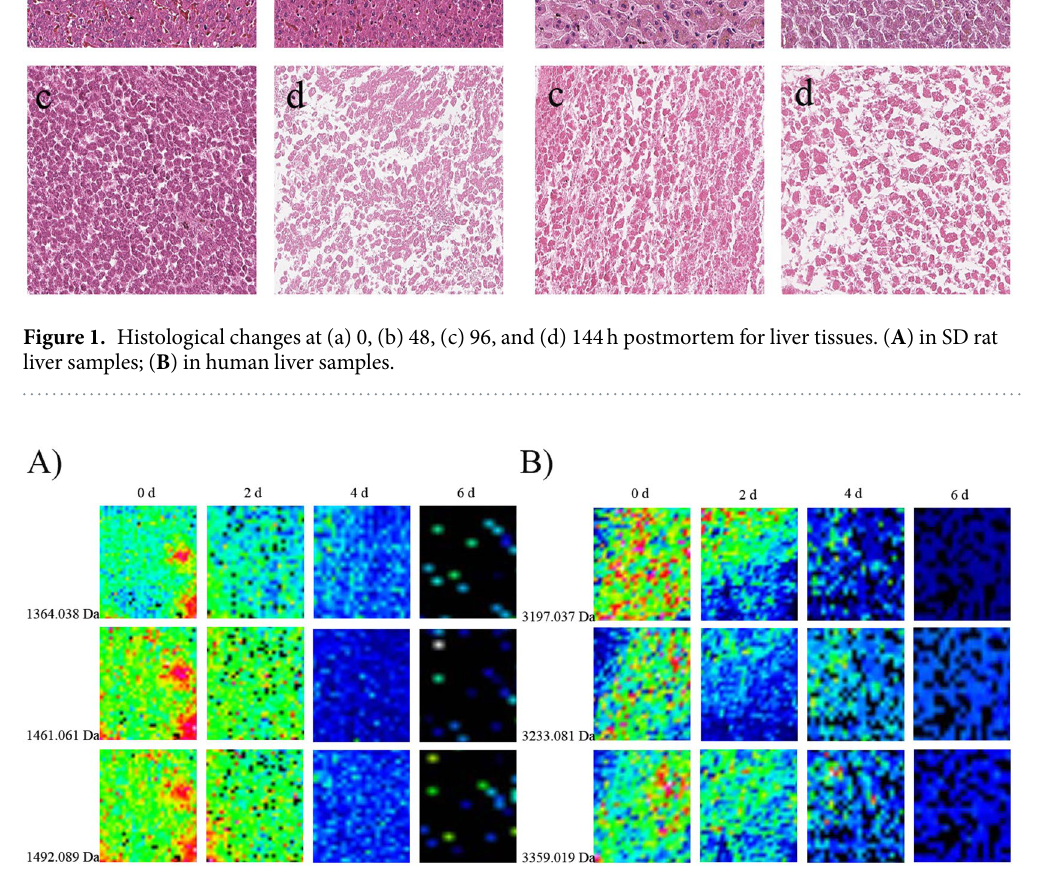
Figure 2. Ion signals showing an obvious change at different PMIs. ( A ) In SD rat liver samples; ( B ) in human liver